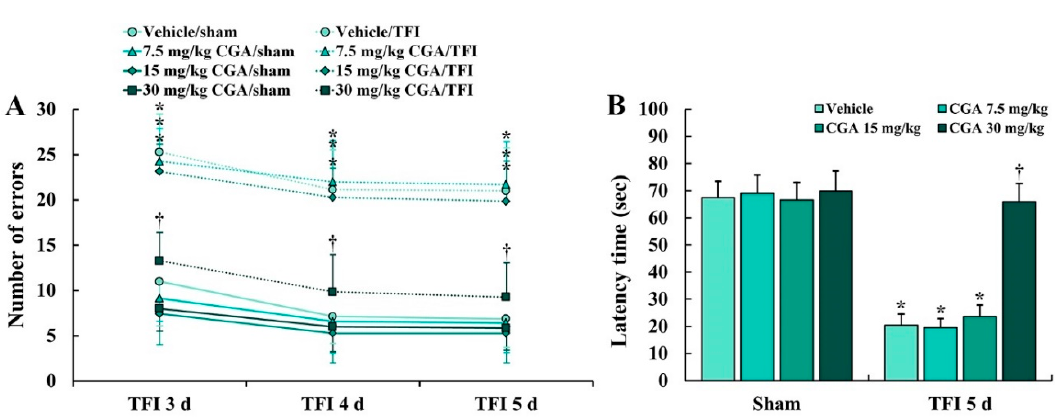
Figure 1. ( A ) Numbers of errors in 8-ARMT in the vehicle/sham, vehicle/ transient forebrain ischemia (TFI), chlorogenic acid (CGA) (7.5, 15 and 30 mg/kg)/sham and CGA/TFI groups at 3, 4 and 5 days after TFI. The numbers of the errors in the 30 mg/kg CGA/TFI group were remarkably reduced after TFI. ( B ) Latency time in the passive avoidance test (PAT) in the vehicle/sham, vehicle/TFI, CGA/sham and CGA/TFI groups at 5 days after TFI. In the 30 mg/kg CGA/TFI group, the latency time was significantly increased compared to that in the vehicle/TFI group. The bars indicate the means ± SEM ( n = 7 in each group, * p < 0.05 vs. corresponding sham group, † p < 0.05 vs. vehicle/TFI group).